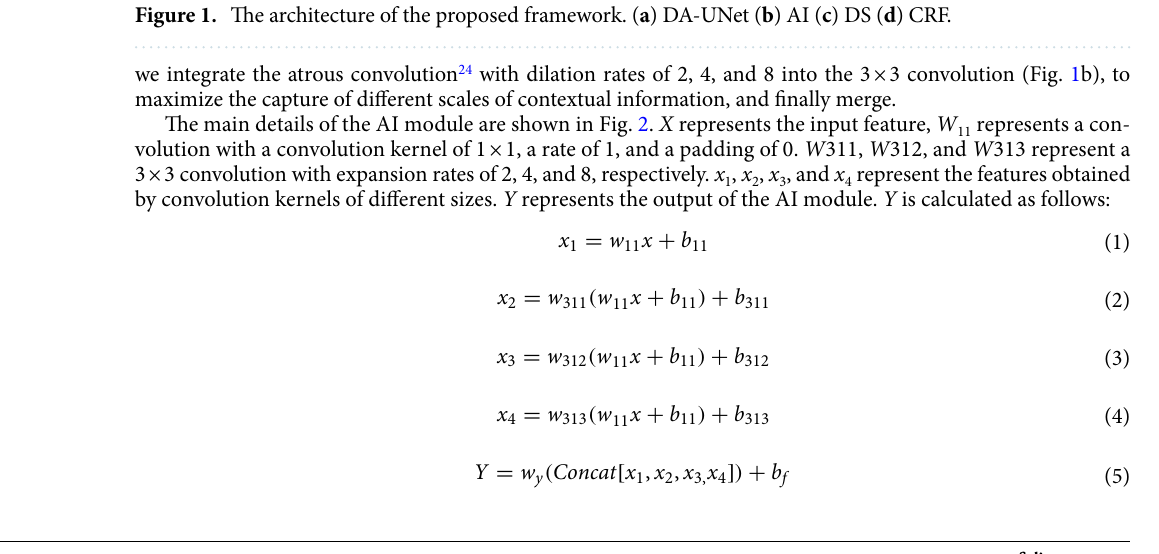
Figure 1. The architecture of the proposed framework. ( a ) DA-UNet ( b ) AI ( c ) DS ( d )